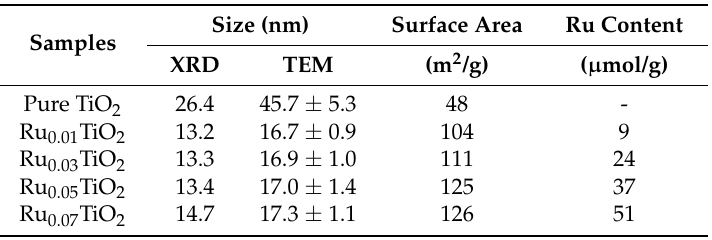
Table 1. The physical properties of the